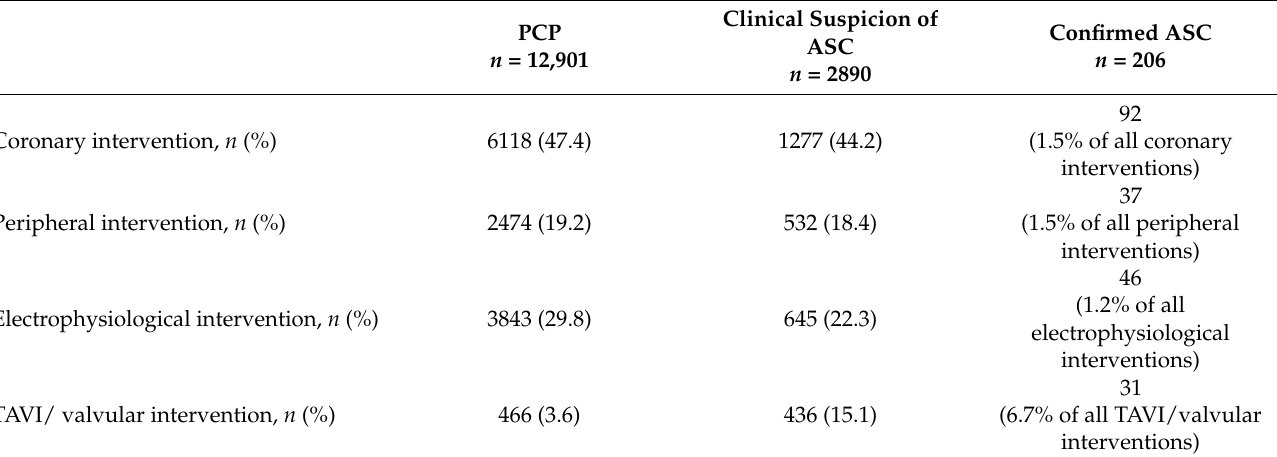
Table 1. Percutaneous cardiovascular procedures and corresponding access site complication according to procedure type.